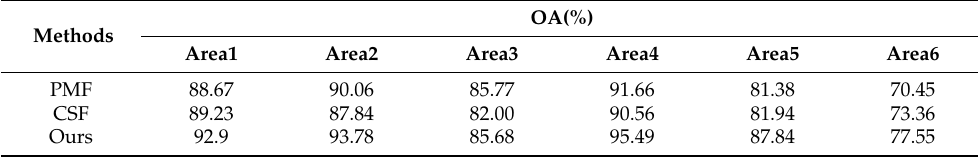
Figure 10. Some visualized results on Southern China dataset. Points in red and blue denote the misclassified non-ground and ground points, respectively. GT denotes the Ground Truth while PMF and CSF denote the Progressive Morphological Filter and the Cloth Simulation Filter, respectively. Table 6. Comparison with rule-based methods on the Southern China